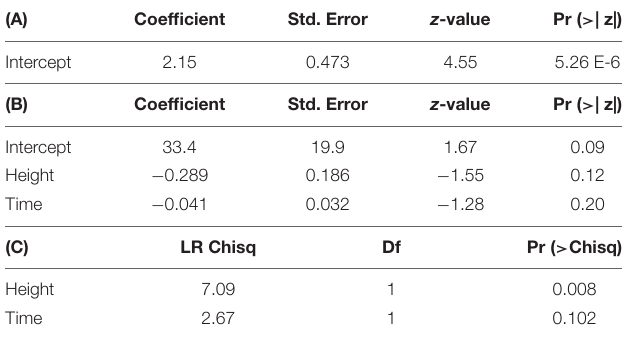
TABLE 5 | (A) Output of logistic regression model predicting dsRNA recovery in stem tissues. (B) Output of logistic regression and (C) analysis of deviance table (type III SS) for model predicting dsRNA recovery in foliar